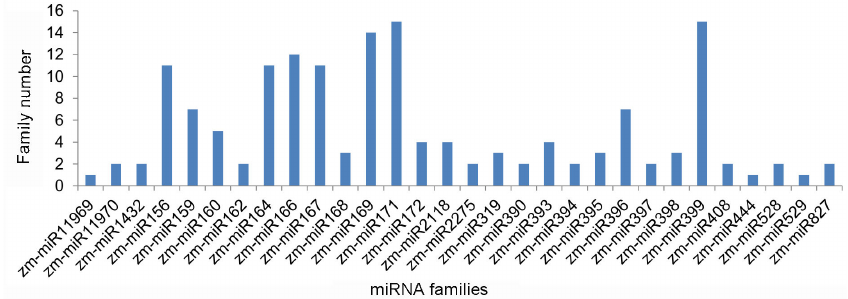
Figure 2. The number of family members and the abundance of miRNA